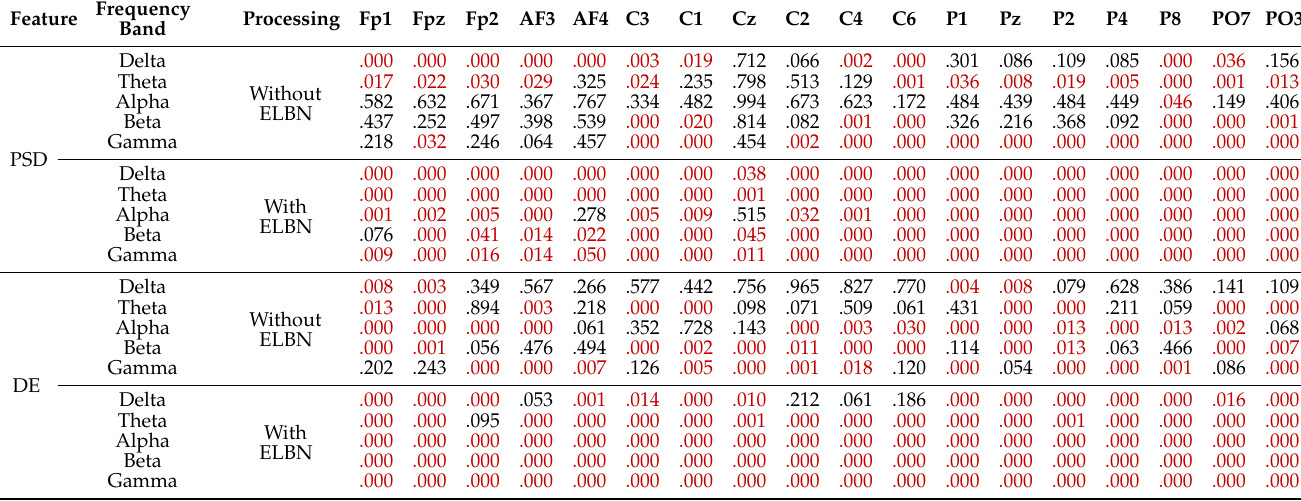
Table 9. The recognition results (mean accuracy and standard deviation) of DE features with different TW lengths. The red color highlights the results with statistical significance ( p ≤